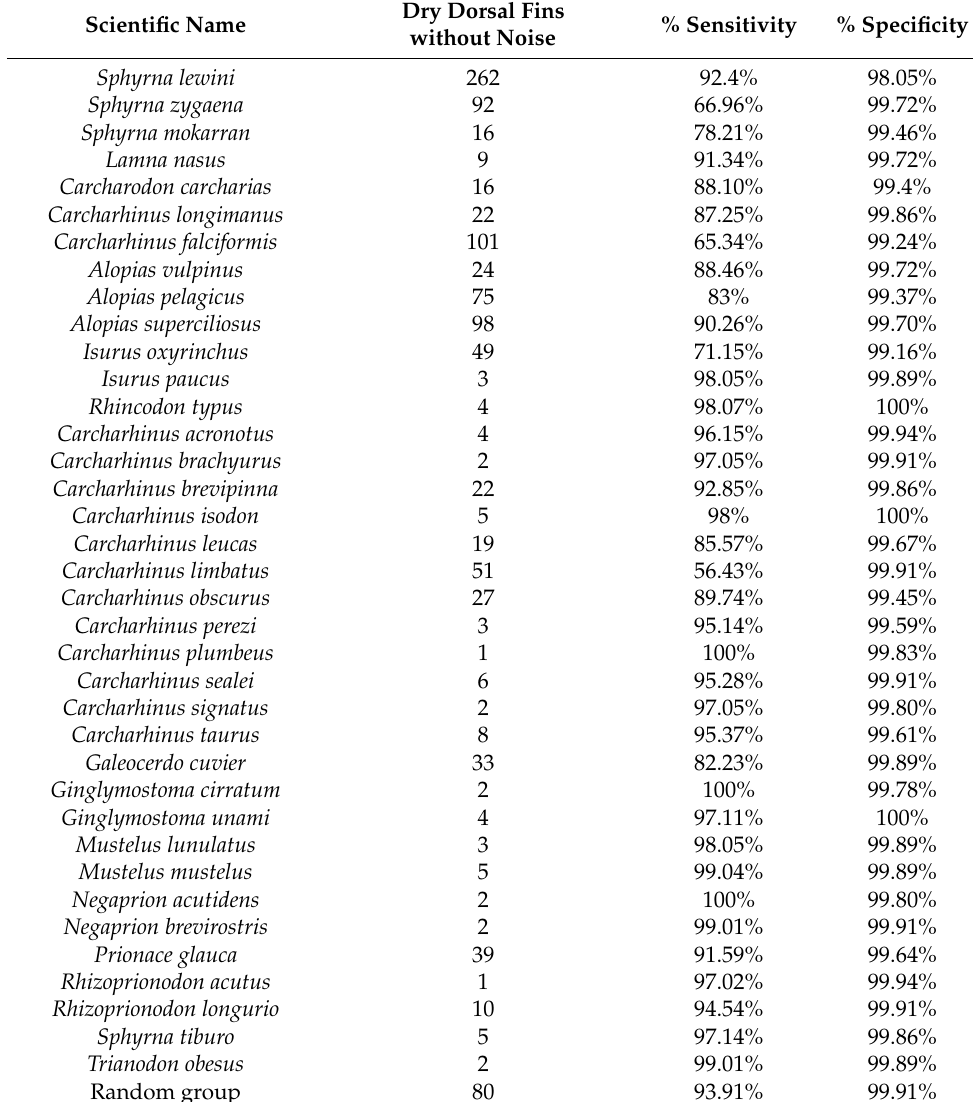
Table 4. Sensitivity and specificity percentage of each dry dorsal fin shark species using the neural network with 90%